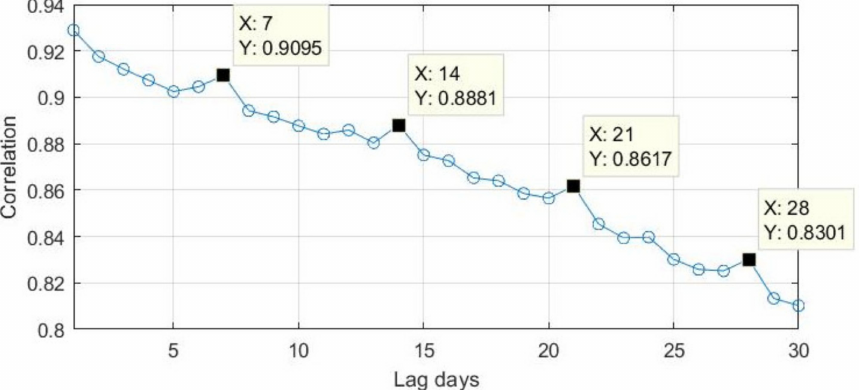
Figure 7. Correlation plot for 30 lag